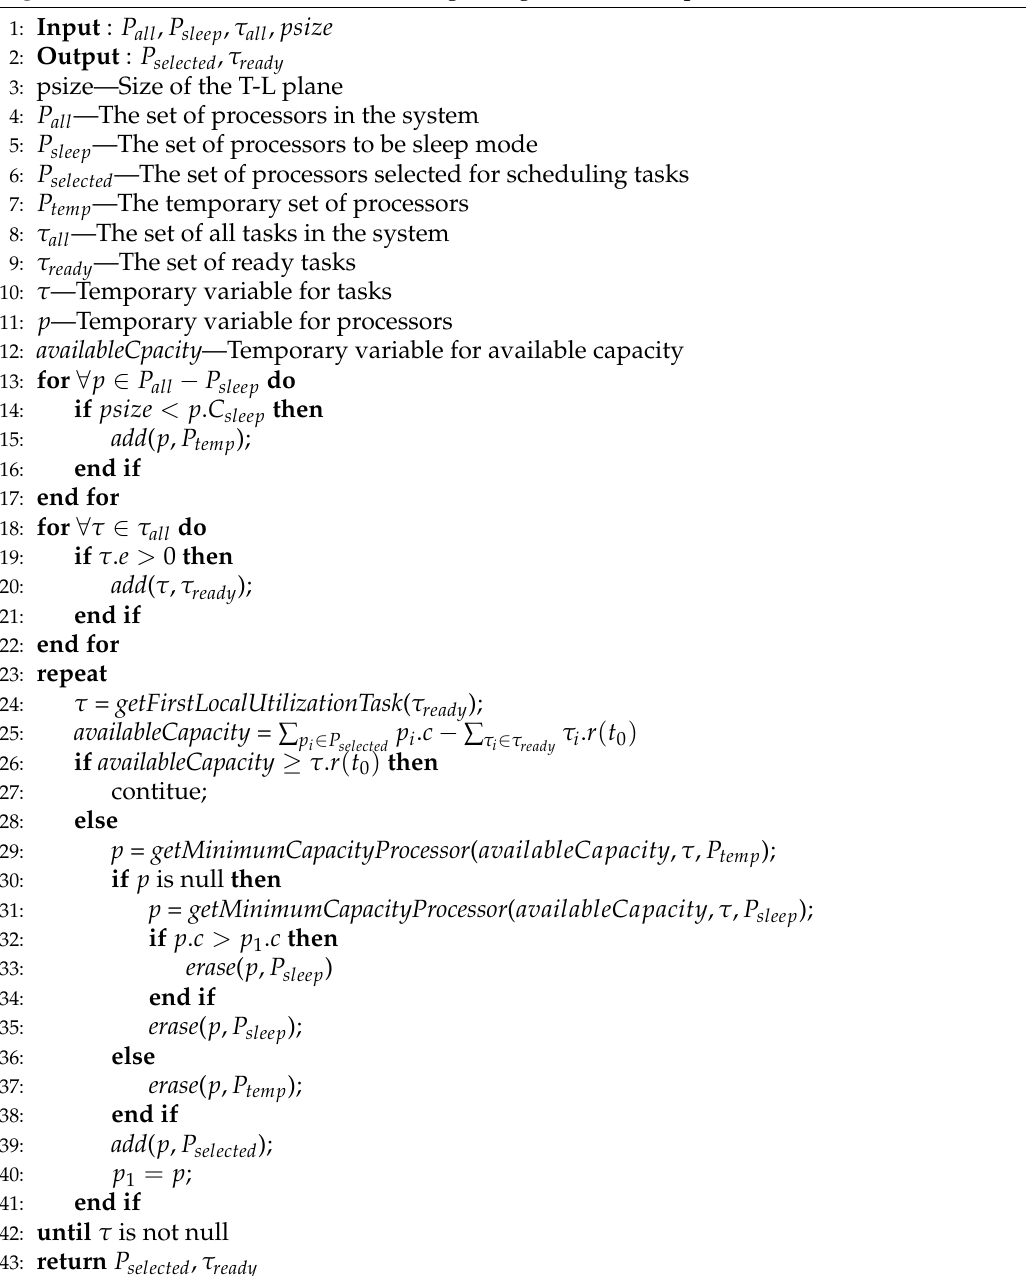
Algorithm 1 Processor selection of the beginning time of a T-L